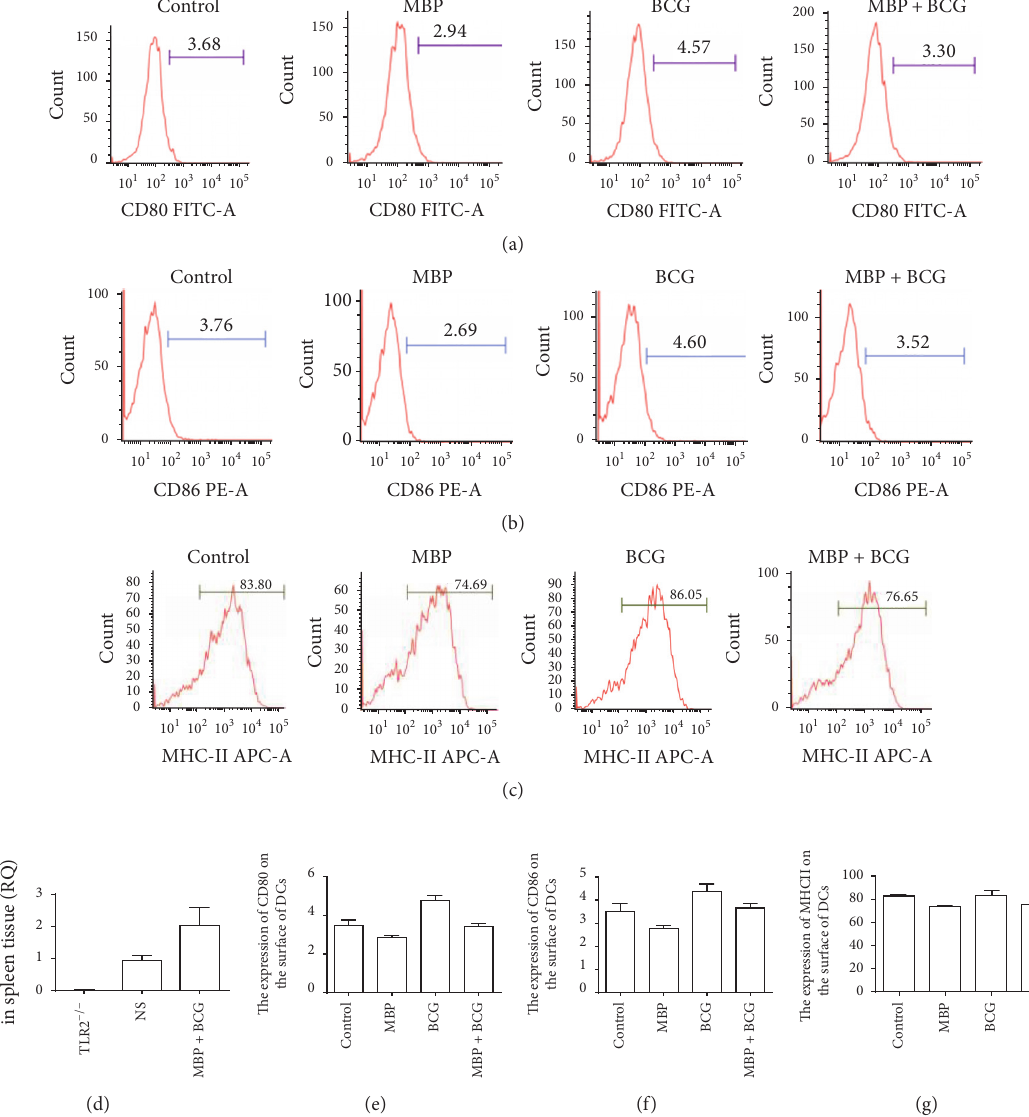
Figure 5: Effect of the combination of MBP and BCG on the phenotypic maturation of DCs from TLR2 −/− mice. Splenic DCs from TLR2 −/−